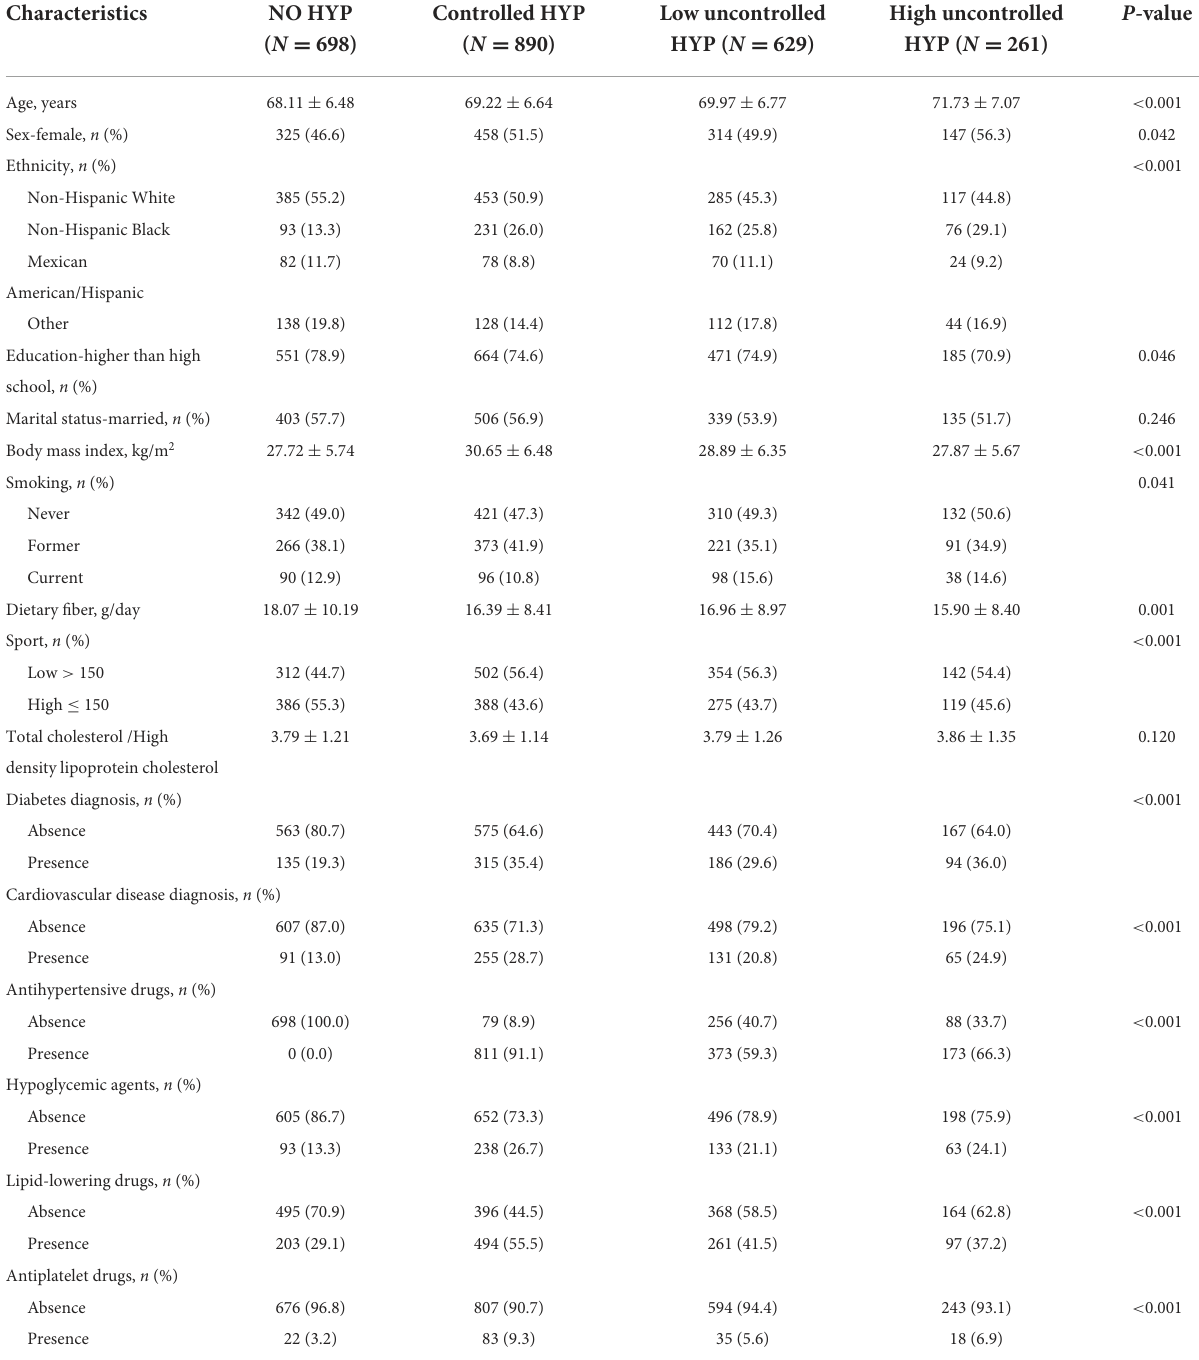
TABLE 2 Characteristics of participants aged 60 years and older from the National Health and Nutrition Examination Survey (NHANES) (2011–2014).